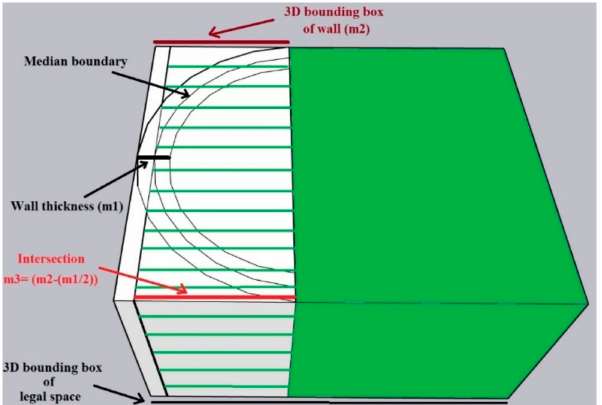
Figure 11. Using (thickness of intersection between 3D bounding box of the wall and 3D bounding box of legal space) for identifying a Median boundary (a curved